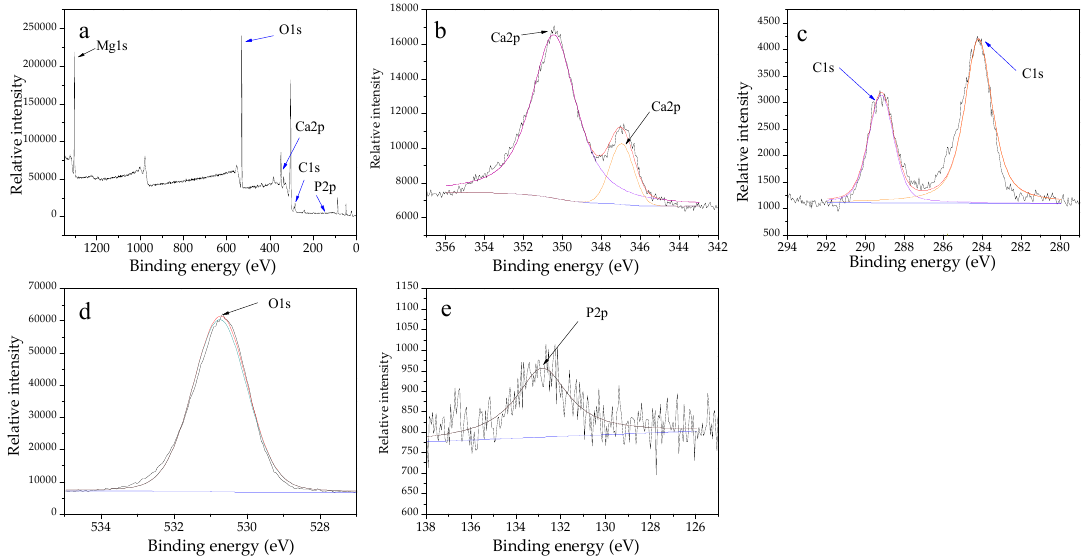
Figure 6. XPS results of the biotic aragonite at Mg/Ca ratio of 8. XPS spectrum of aragonite surface ( a ) and the Ca 2p ( b ), C 1s ( c ), O 1s ( d ), and P 2p ( e ) spectra.